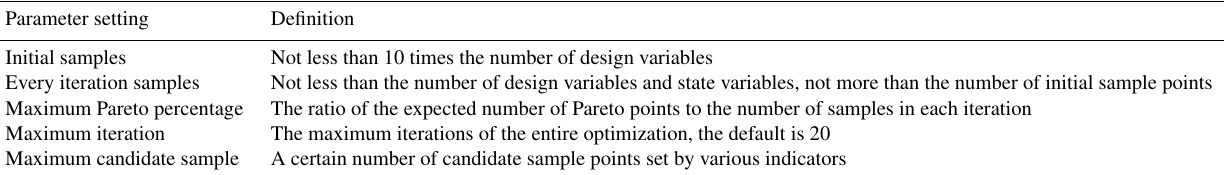
Table 1. Main parameter settings.